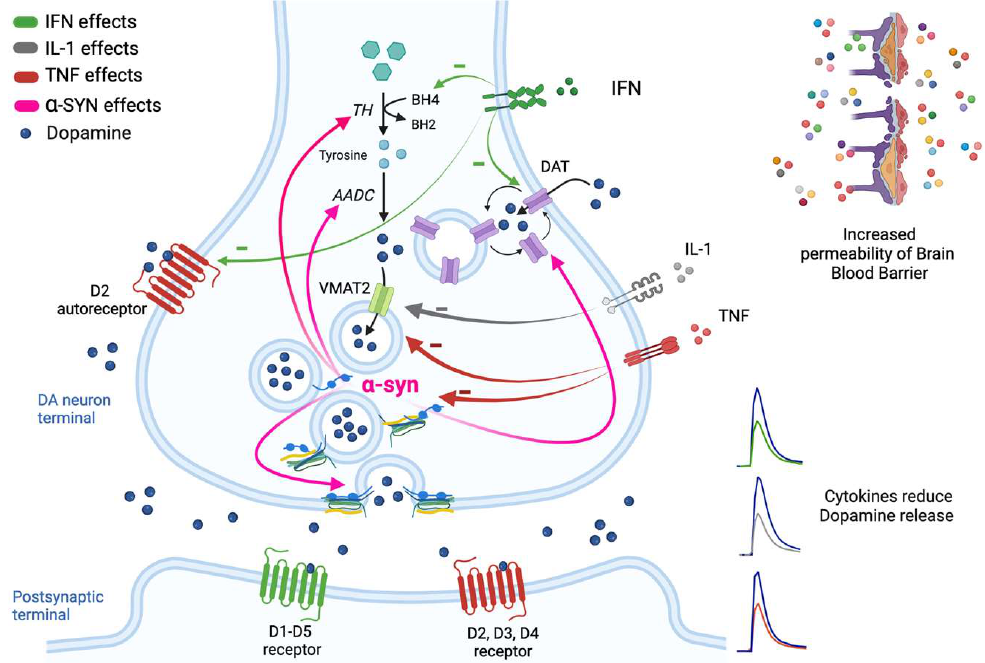
Figure 1. Potential mechanisms of cytokine effects on DA neurotransmission. Simplified representation. Cytokines released from peripheral immune cells or those produced in the brain by activated astrocytes and microglia lead to decreased concentrations of synaptic DA by effect on its synthesis and release. DA is synthesized in the cytoplasm by the action of tyrosine hydroxylase (TH) and amino acid decarboxylase (AADC). Once synthesized, DA is immediately sequestered into vesicles by the vesicular monoamine transporter 2 (VMAT2) and then released into the synaptic cleft where it binds to its postsynaptic receptors. DA signaling at synapse is terminated by degradation or reuptake of DA via the DA transporter (DAT). Inflammatory cytokines (e.g., IFN) may in fact impair the availability of DA by contributing to the oxidation of BH4, the cofactor required for the conversion of tyrosine to L-DOPA. They may also decrease the expression or function of VMAT2 (e.g., IL-1 and TNF) and/or increase the expression or function of DAT (e.g., IFN). The disruption in DA homeostasis induced by cytokines (e.g., TNF) may also be consequence of α -syn changes; in fact, α -syn is involved in the regulation of TH and AADC activity, in the regulation of synaptic vesicle fusion into the synaptic cleft, and in the trafficking of DAT to the cell surface. Finally, an inhibitory effect on release is also caused by a reduction in D2 receptors (e.g., IFN). DA production is mediated by the activity of tyrosine hydroxylase (TH), the rate- limiting enzyme of catecholamine synthesis. The activation of TH determines the hy- droxylation of tyrosine to L-DOPA which, after decarboxylation to DA by the amino acid decarboxylase (AADC), is loaded into the synaptic vesicle. TH requires ferrous iron and tetrahydrobiopterin (BH4) as cofactors to perform the reaction (Figure 1). Post-translation modifications, such as phosphorylation reactions, influence the affinity for the cofactor BH4 causing changes in DA release